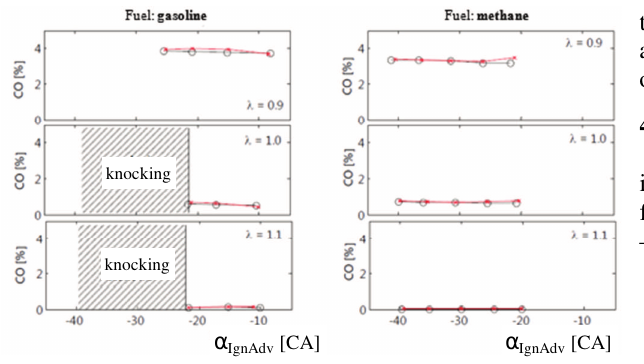
Fig. 10. Carbon monoxide concentration in the exhaust gas of petrol and methane fueled engine